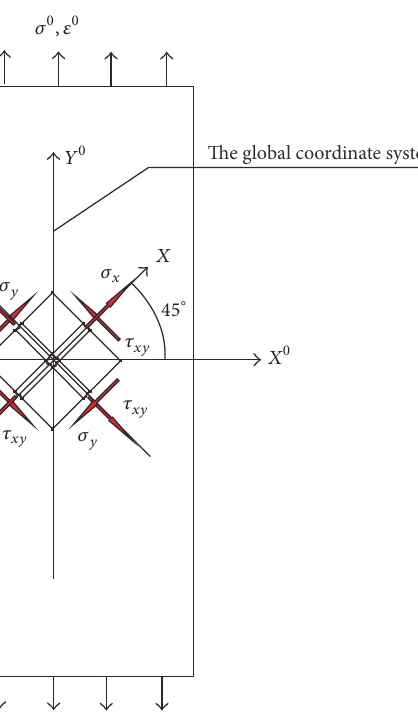
Figure 4: Schematic of a plate subject to tension.